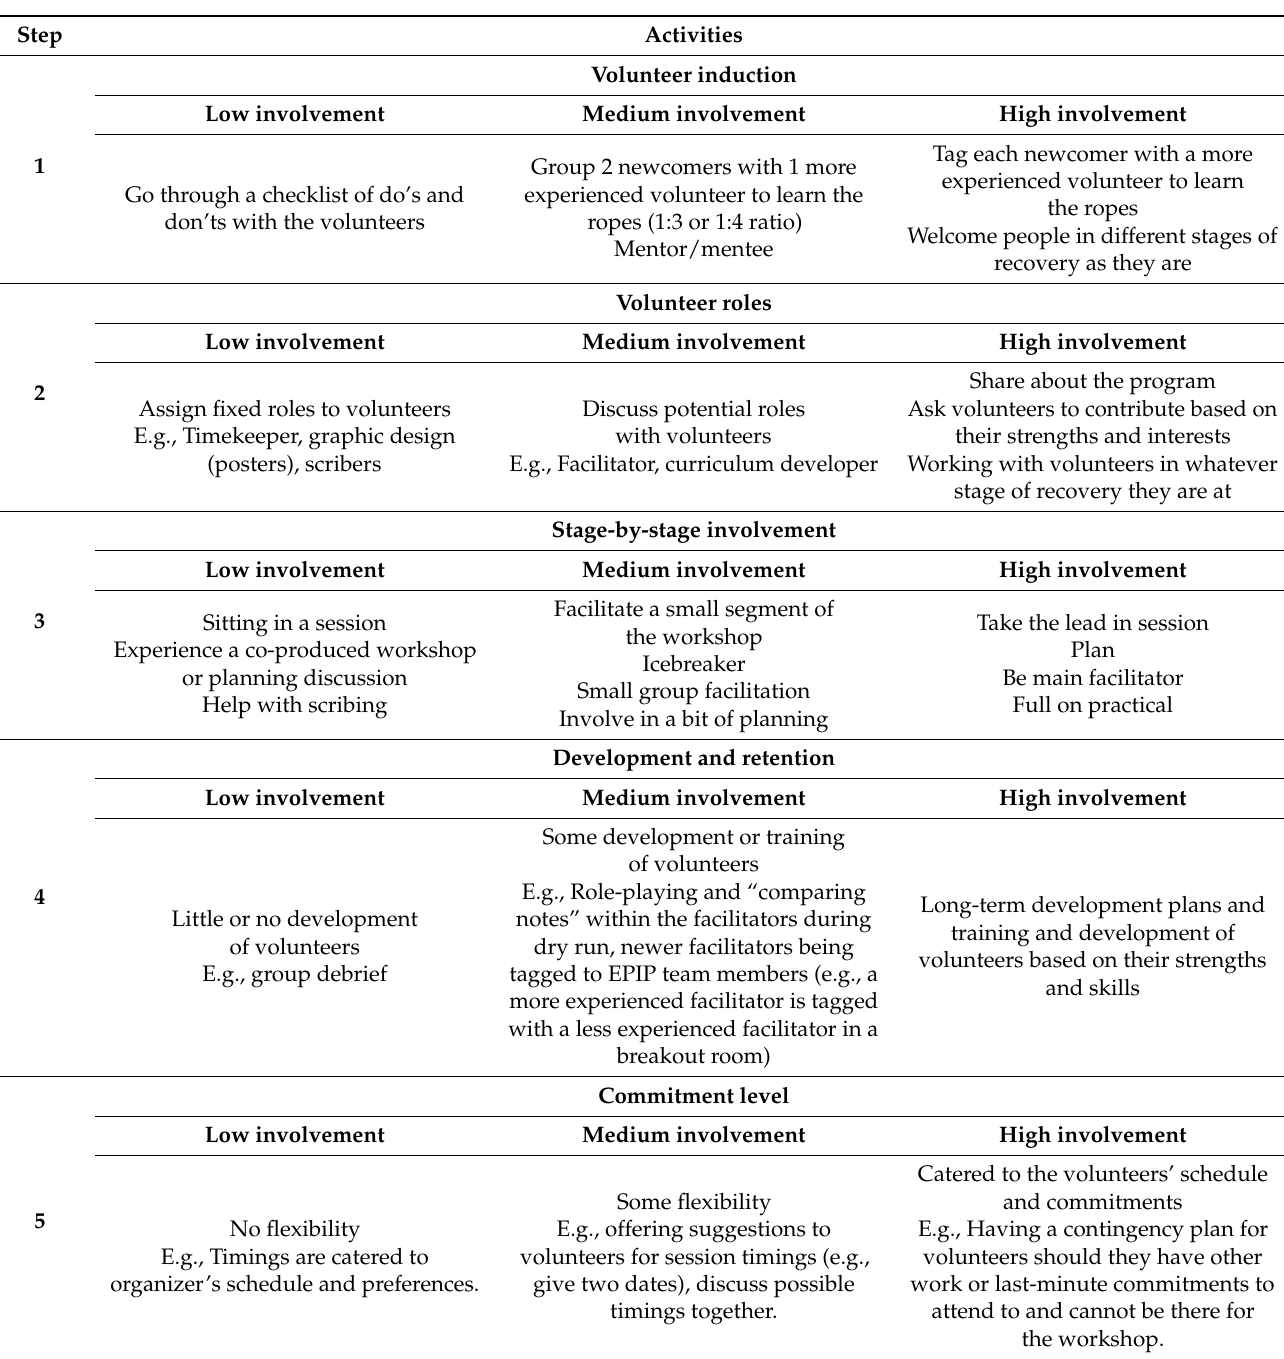
Table 3. A table to summarize five key areas for the on-boarding of